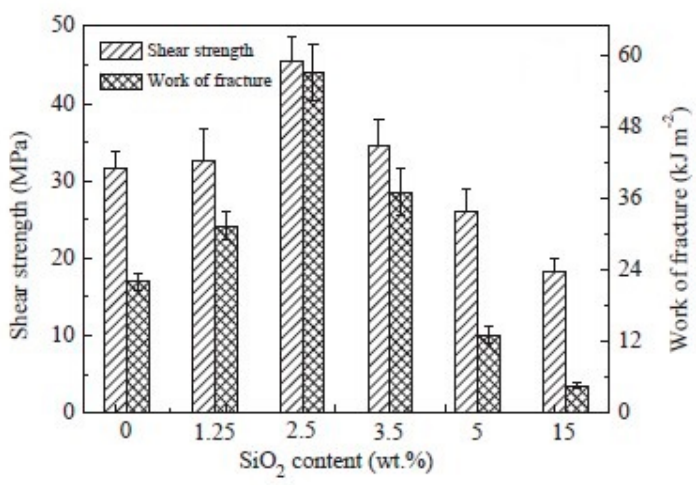
Figure 12. Adhesive strength and work of fracture as a function of nanosilica addition level [44].